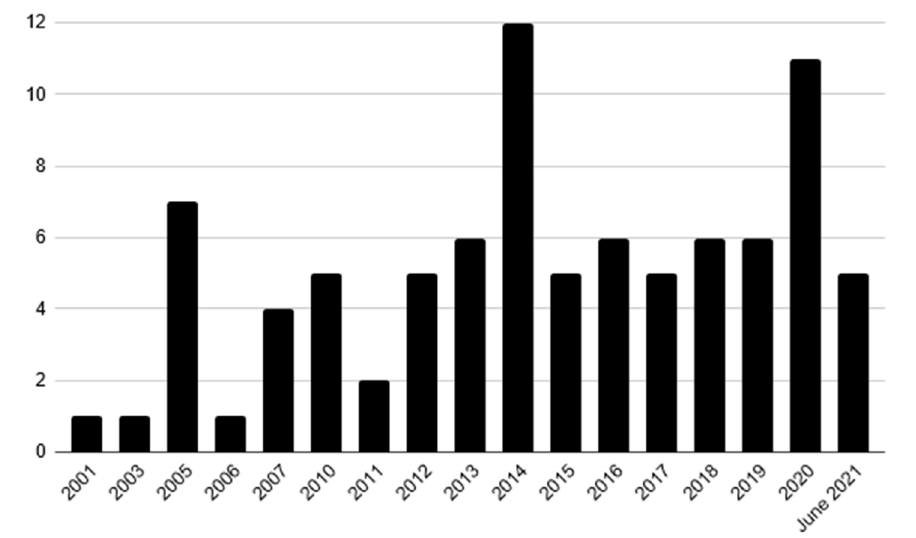
Figure 2. Number of included reports by publication year.